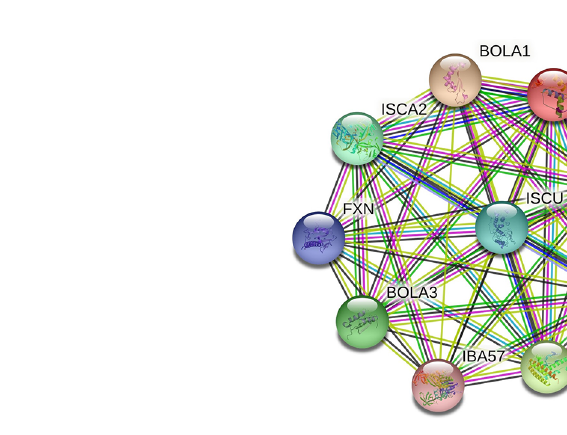
FIGURE 3 | Grx5 protein interaction networks. The red dots represent the target protein Grx5. Other colored dots represent proteins that interact with Grx5. The names of all proteins are abbreviated to the top right of